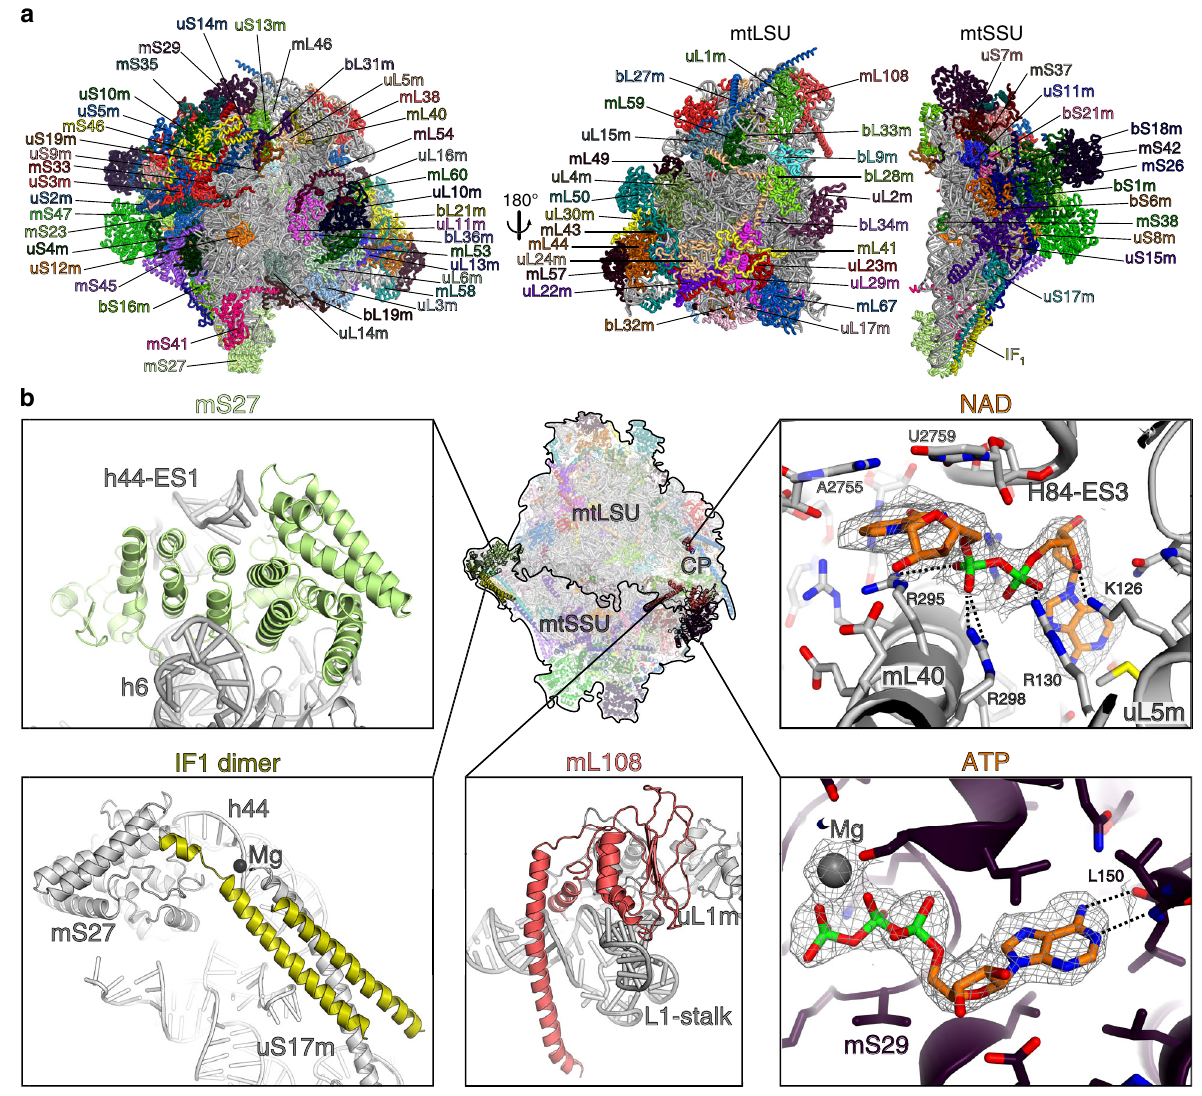
Fig. 1 Structure of the fungal mitoribosome and additional features. a Overall structure of the complete mitoribosome and its subunits with indicated mitoribosomal proteins. b Examples of additional features. Remodeled and reannotated mS27 interacts with h44-ES1. The mitoribosomal component IF 1 dimer bound to h44-ES1 and uS17m extension. NAD binding pocket in the CP formed by uL5m, mL40, and H84-ES3. The mitoribosomal component mL108 is located in the L1 stalk. Nucleotide-binding pocket of mS29 bound with chemically favorable ATP shown with